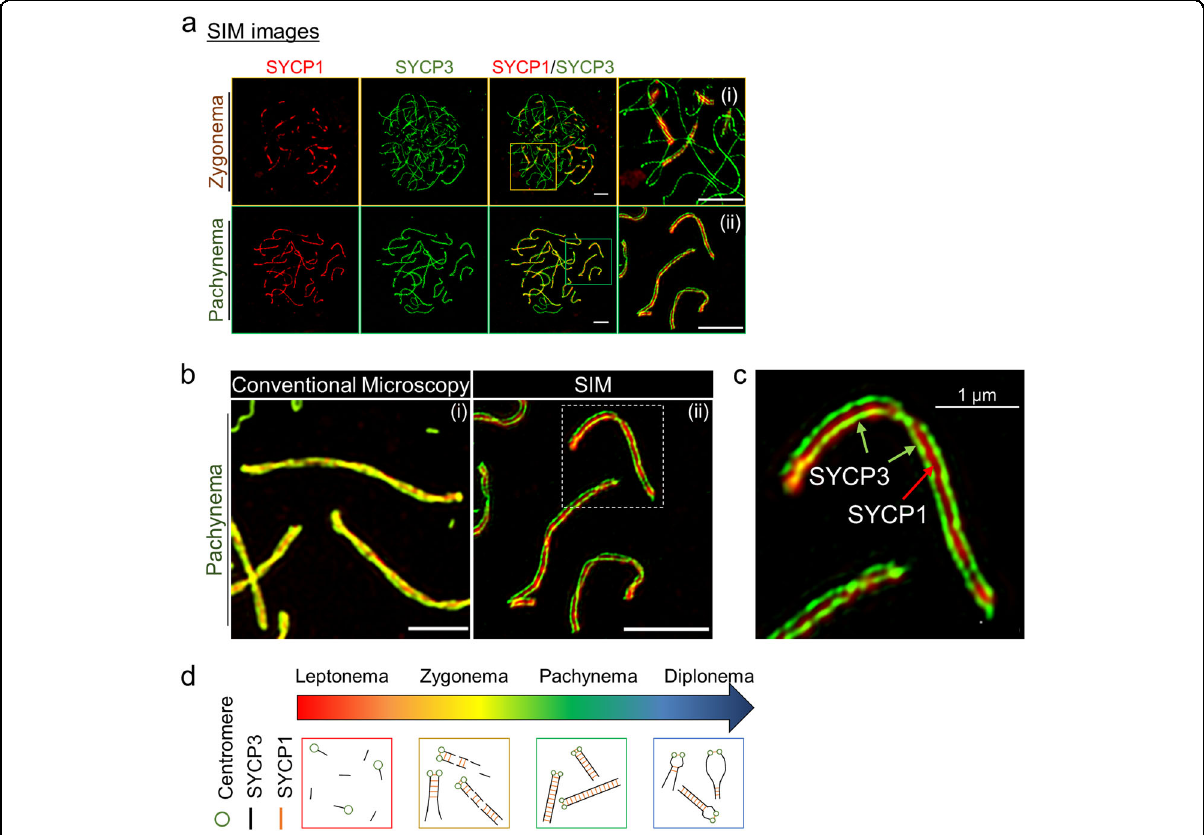
Fig. 2 Super-resolution imaging of SYCP1 and SYCP3. a Immuno fl uorescence imaging of SCs by structured illumination microscopy (SIM). Magni fi cation images of zygonema and pachynema are shown in (i) and (ii), respectively. Bars represent 2.5 μ m. b Comparison of conventional microscopy and SIM for zygonema and pachynema. Panel (i) is the image from the conventional microscopy and panel (ii) is that acquired by SIM. Bars represent 2.5 μ m. c Magni fi ed images from b (ii) stained with anti-SYCP1 and anti-SYCP3 in pachynema. SYCP1 and SYCP3 were used to visualize central elements and chromosome axes for all stages of meiotic prophase I. d Schematic diagram of SC formation in meiotic prophase I. From the leptonema to the pachynema, the two lateral elements with a central element are assembled into SC with meiosis-speci fi c proteins, including SYCP1 and SYCP3. In the diplonema stage, SC disassembly, induced by the dissociation of SC proteins, ensues and homologous chromosomes begin to separate, but they are held together by